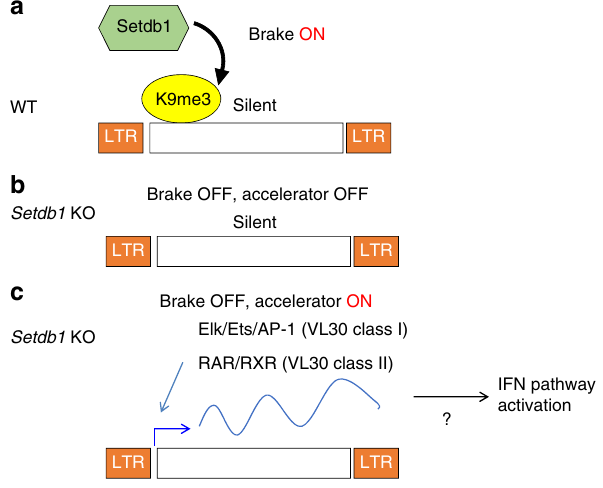
Fig. 6 Model of Setdb1 function in ERV silencing. a Setdb1 deposits H3K9me3 at ERV loci generally in differentiated cells, not only in ESCs. b In Setdb1 KO cells H3K9me3 is reduced at ERV loci. However, TFs are required for each ERVs to get depressed. Without accelerator (TFs) ERVs are not expressed even without brake (H3K9me3). c For example, in Setdb1 KO iMEFs derepression of VL30 class I require Elk, Ets, and AP-1 TFs. VL30 class II is expressed only in the presence of RA in Setdb1 KO iMEFs.